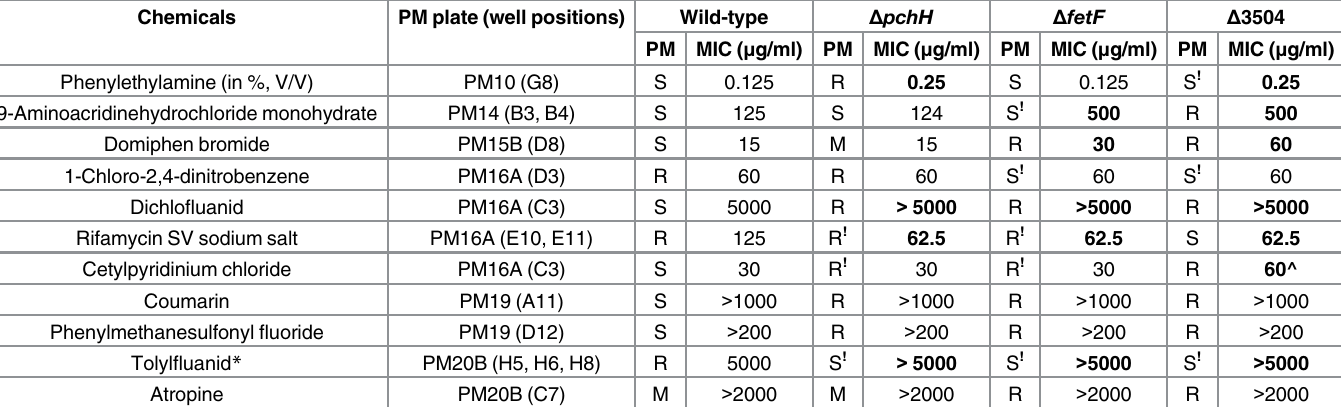
Table 2. Sensitivity of Pf-5 and derivative strains to antibiotics and other compounds.